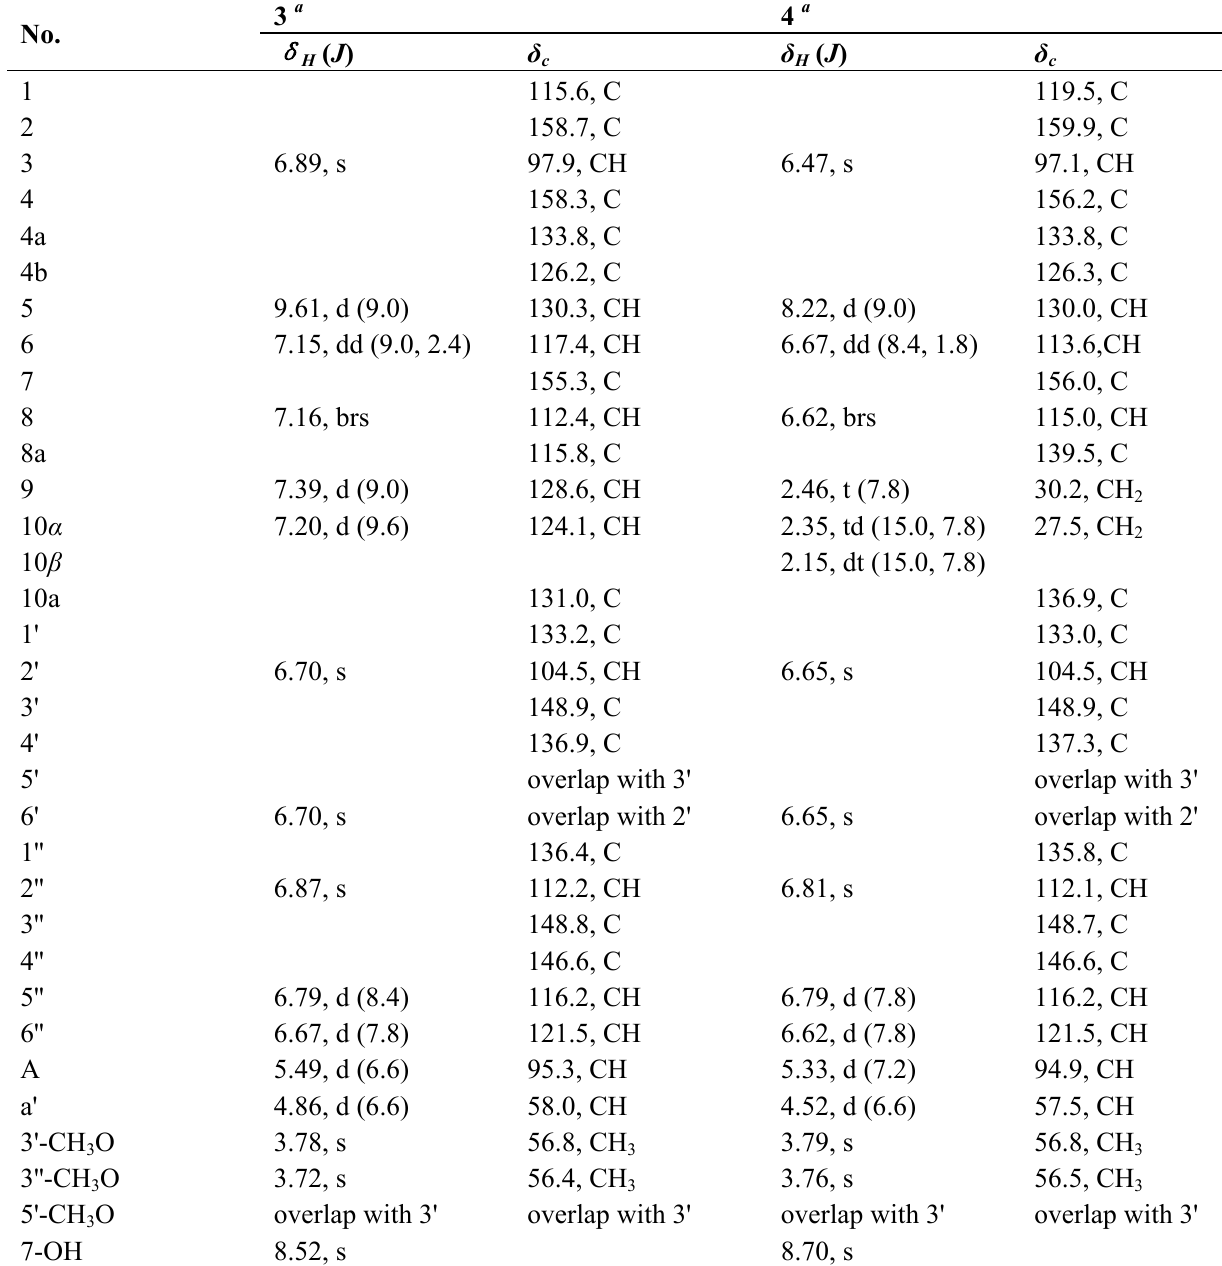
Table 2. NMR data for compounds 3 – 4